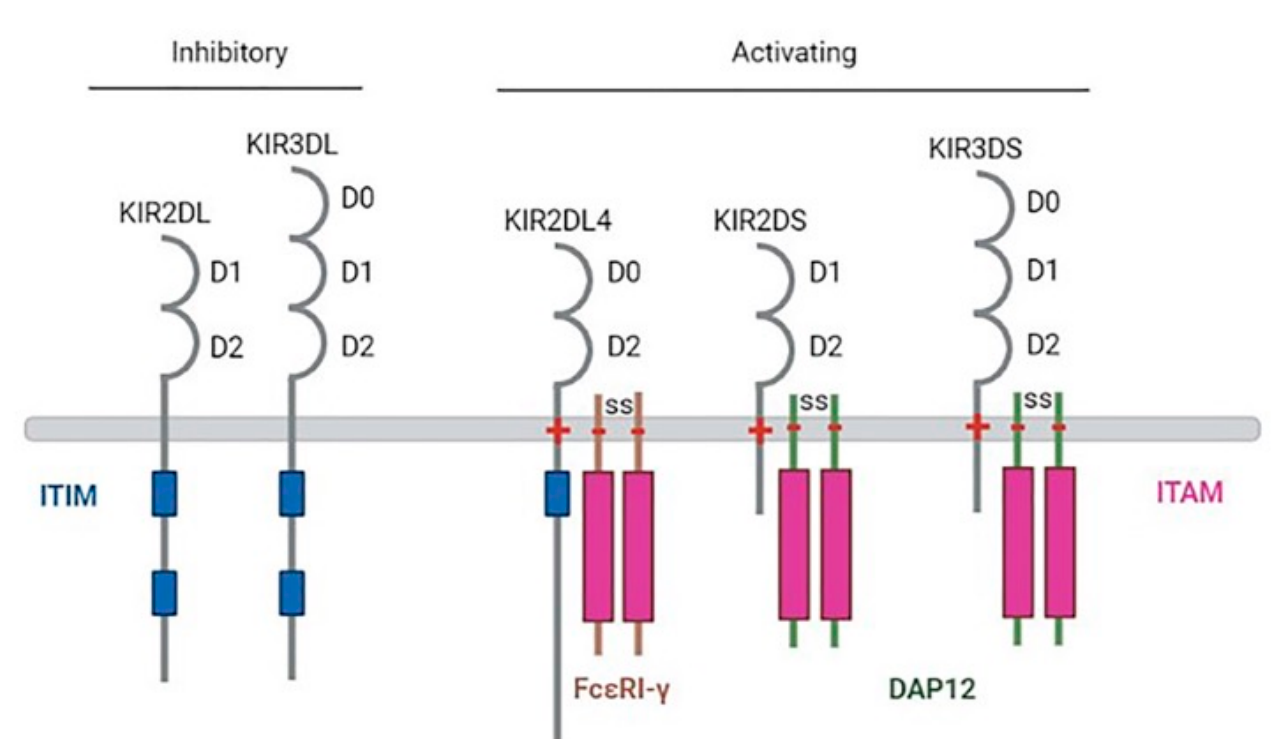
Figure 3. Representation of inhibitory and activating KIRs structure. Receptors with long cytoplasmic domains contain one or two immunoreceptor tyrosine-based inhibitory motif sequences (ITIMs), represented in blue, that provide inhibitory function. The short cytoplasmic KIR and the long-tailed KIR2DL4 are activating receptors, which contain a basic amino acid (+) within the transmembrane domain that interacts with an acidic amino acid ( − ) within the transmembrane domains of signaling adaptor proteins DAP12 (green) or Fc ε RI-c (brown), respectively. These adaptors provide intracellular immunoreceptor tyrosine-based activator motif sequences (ITAMs), in purple, that allow activating function.